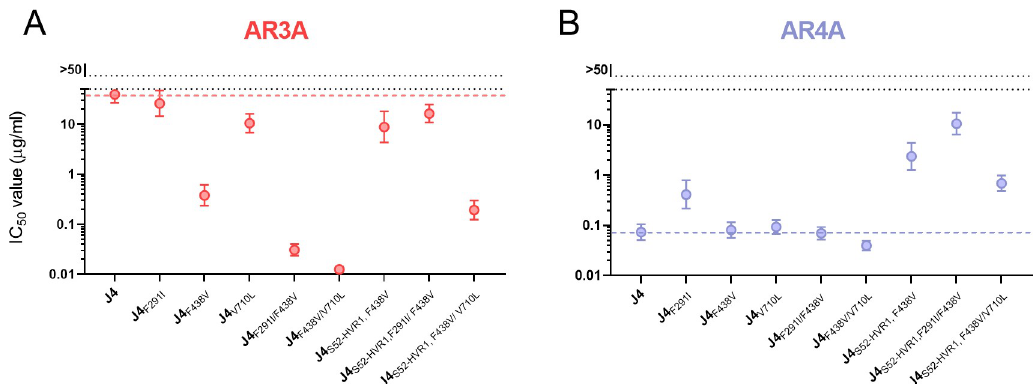
Fig 8. Envelope protein substitutions increase sensitivity of J4 HCVcc to AR3A with little effect on AR4A sensitivity. Neutralization by the bNAbs (A) AR3A and (B) AR4A of the indicated recombinants. The viruses were incubated in four technical replicates with a 5-fold dilution series of the bNAbs, starting at 50 μ g/ml, along with eight technical replicates of virus only. 48 hours post-infection the cells were immunostained for HCV antigen, and the number of FFUs/well was counted and normalized to the mean count of wells with virus only. Each dot represents the mean IC 50 value of the indicated recombinants. Error bars represent the 95% confidence intervals (CI 95 ). The colored broken line represents the IC 50 value of unmodified J4. The data was analyzed using three-parameter dose-response with the top value set to 100 and lower value set to 0, to calculate IC 50 and CI 95 using GraphPad Prism